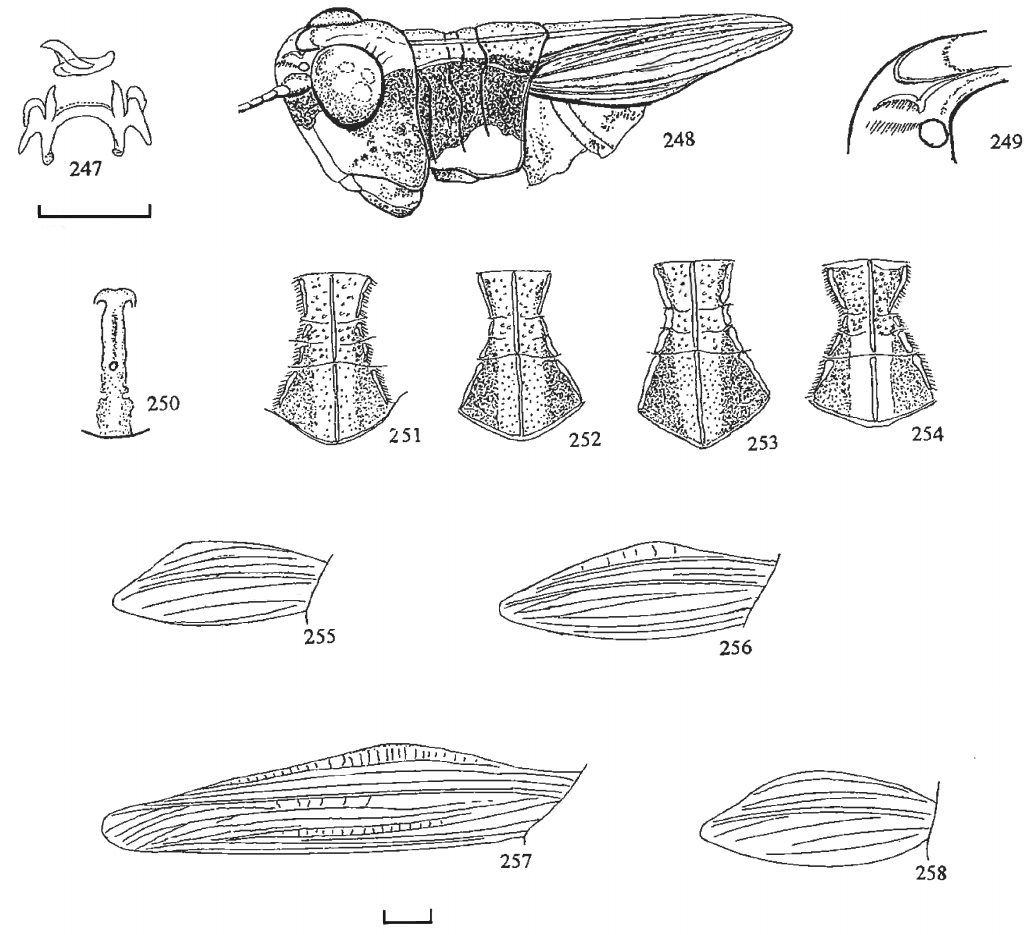
Figs 247–258. Tribe Gymnobothrini. Gymnobothrus rimulatus. Fig. 247. Epiphallus; 248. Female oblique view head, pronotum and tegmina; 249. Male oblique view vertex; 250. Male frontal ridge; 251–253. Variation in male pronotal disc; 254. Same, intermediate to subsp. pullus ; 255–257. Male tegminal variation; 258. Male tegmen intermediate to subsp. pullus . Scale lines all represent l mm: that under Fig. 247 applies to Figs 247 and 249; that under Fig. 257 applies to all the rest.